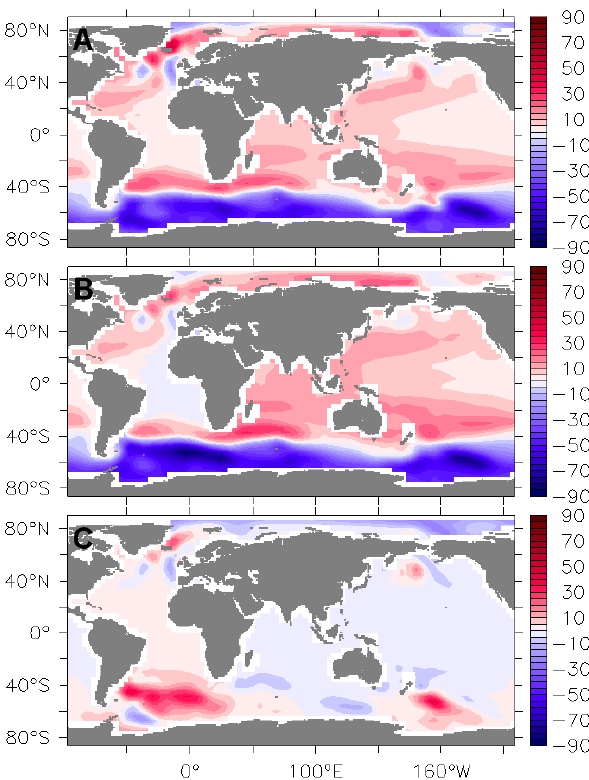
Fig. 12. (A) Sum of the three anomalous sea-level fields given in Fig. 11, (B) sea-level anomaly resulting from application of all three forcings, (C) difference of the fields in (A) and (B) .